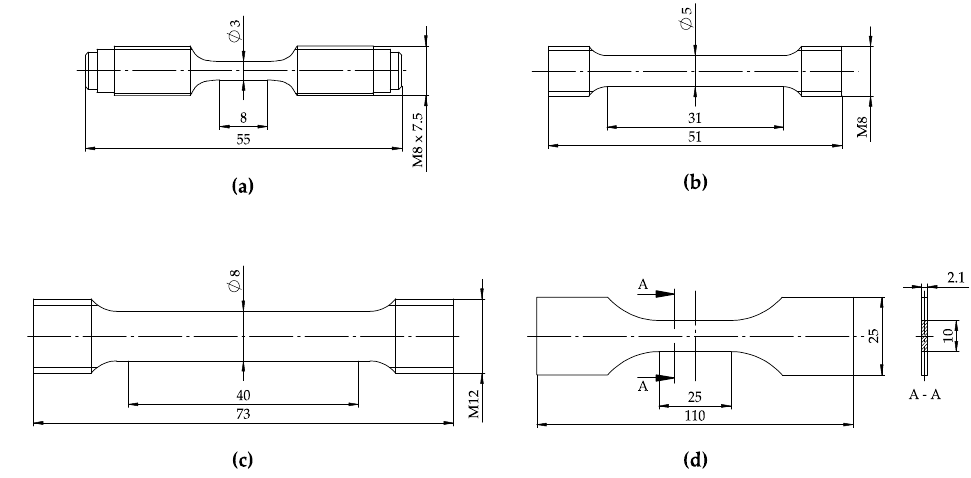
Figure 2. Technical drafts of tensile specimens with essential dimensions: ( a ) fatigue specimen, ( b ) specimen for tensile tests at room temperature, ( c ) specimen for tensile tests at elevated temperatures, ( d ) specimen for deformation measurements with digital image correlation.